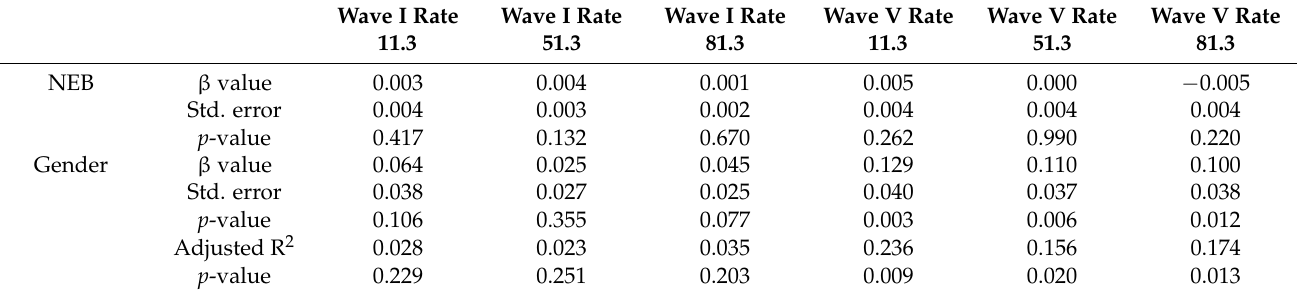
Figure 4. Grand average P300 waveforms of two groups. The X -axis corresponds to latency, and the Y -axis corresponds to ABR wave amplitude measured in nV. Table 4. Results of the regression analyses listing predictors for ABR wave I and V amplitudes (μV).